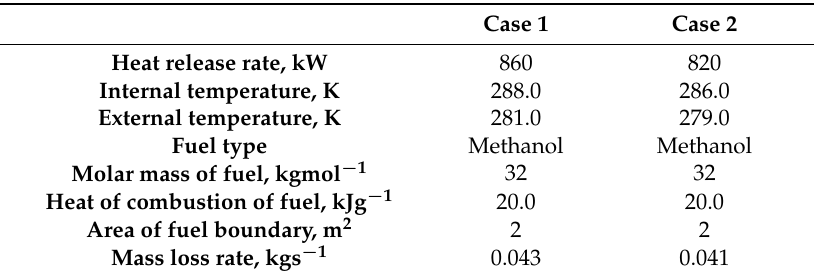
Table 2. Boundary condition of the fuel bed for Case Study 1 and Case 2.